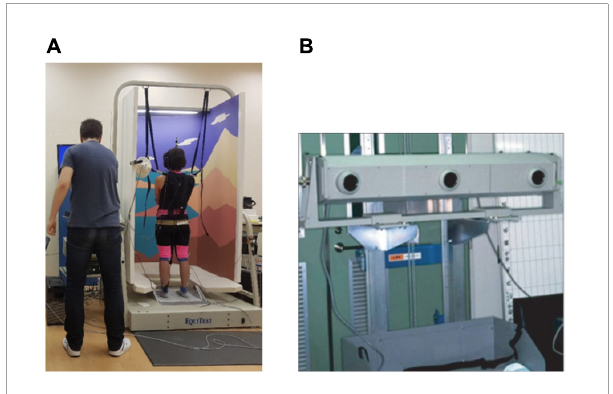
FIGURE1 (A) Neurocom EquiTest complex. (B) Optotrack 3020 motion capture systems.